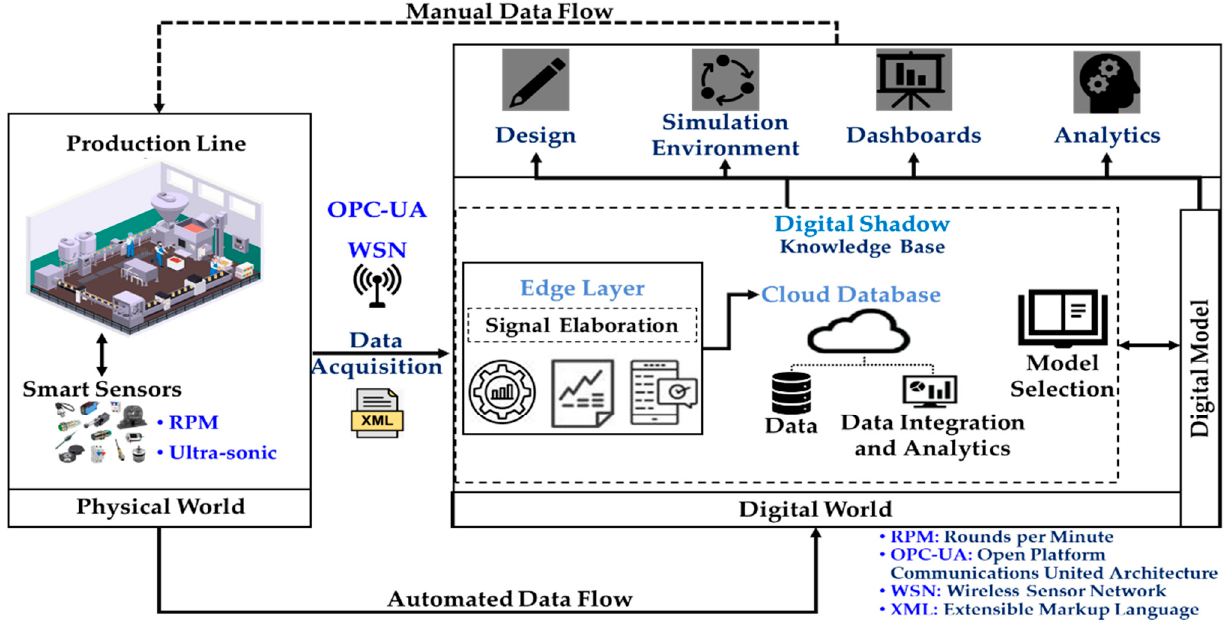
Figure 4. The Proposed Digital Shadow framework.